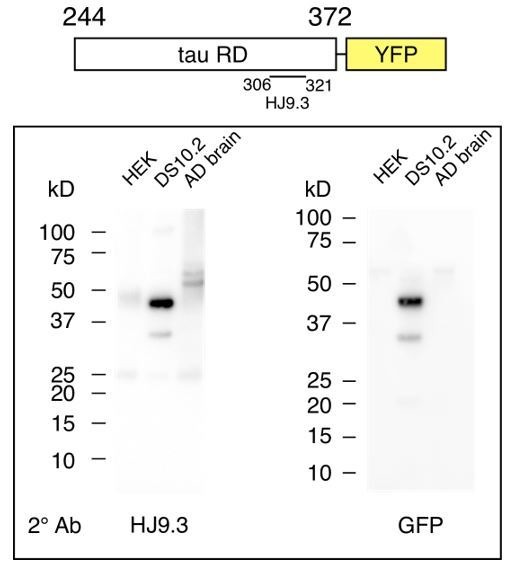
Tau monomer from DS10.2 is predominantly full-length.Diagram indicates tau RD-YFP and the epitope of HJ9.3, which was used for initial